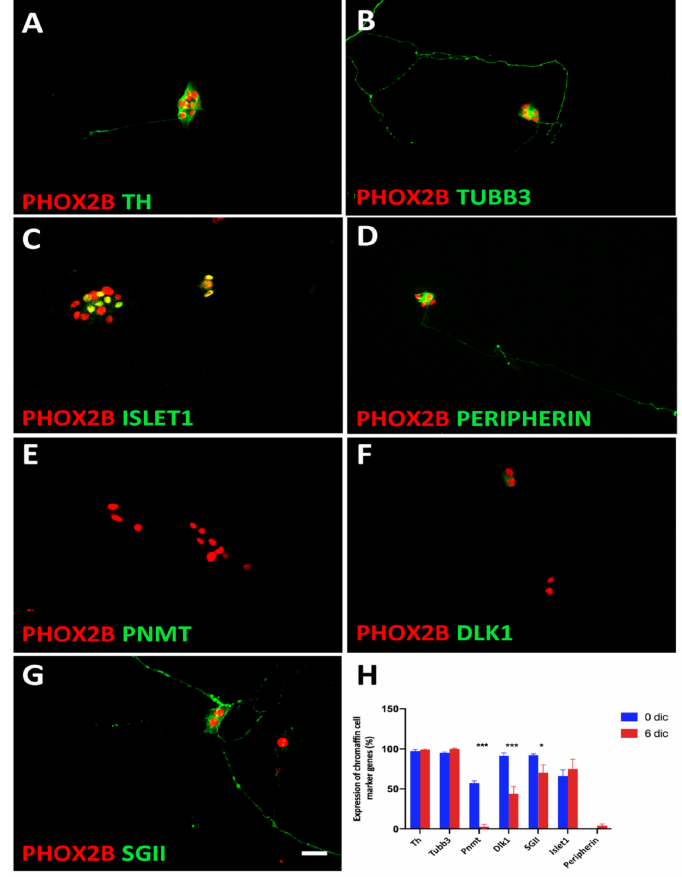
Figure 8. Trans-differentiation of chromaffin cells in culture. Double-immunostaining shows that while TH ( A ) and TUBB3 ( B ) were maintained during the 6d culture period, the chromaffin cell- specific proteins PNMT, DLK1, and SGII are lost or decreased ( E , F , G ). Increased ISLET1 expression does not reach significance ( C , H ). PERIPHERIN is expressed by a very low number of cells both at 3d and 6d in culture ( D , H ). The results are quantified in ( H ). Significant differences marked by * and *** indicate p -values < 0.05 and <0.001, respectively. Magnification bar, 60 µ